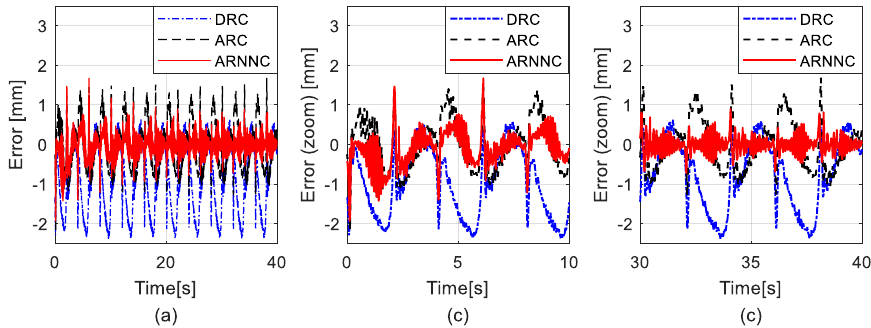
Figure 8. Tracking performances of 90Sin ( 0.5 π t − 0.5 π ) with 5 kg load ( a ) Tracking errors of di ff erent controllers. ( b ) Zoomed tracking errors from 0 to 10 s. ( c ) Zoomed tracking errors from 30 to 40 s.